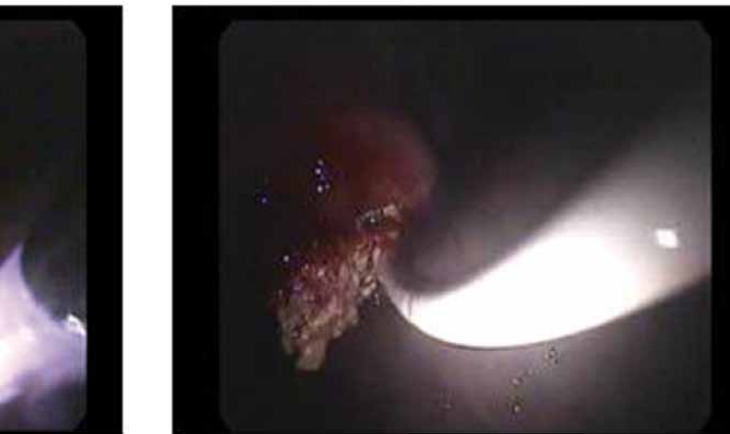
Figure 4 - Dilation of the ostium with a balloon catheter. Figure 5 - Extraction of the stone with the balloon